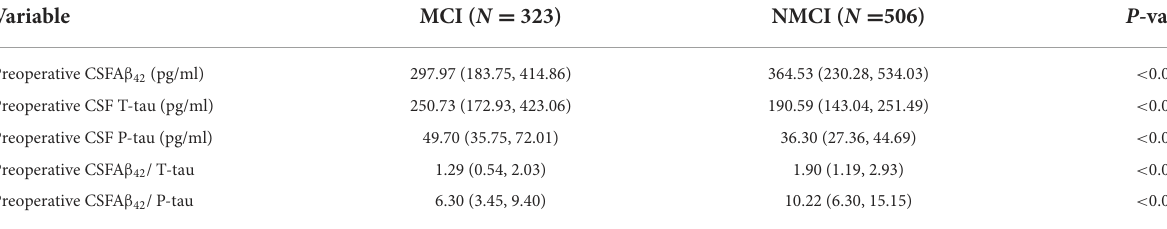
TABLE 2 Comparison of CSF biomarkers of unilateral total knee arthroplasty patients.